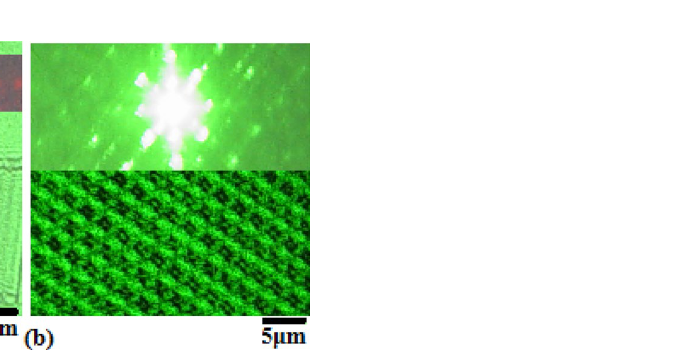
Figure 1. ( a ) Experimental diagram designed for reshaping Gaussian beams to plane wave, in which the telescope is used in inverse optical path. ( b ) Experimental diagram designed for enlarging spot of Gaussian beams, where the beam wave-front can be reshaped by adjusting lens L1 and L2 in the LRTM routing.